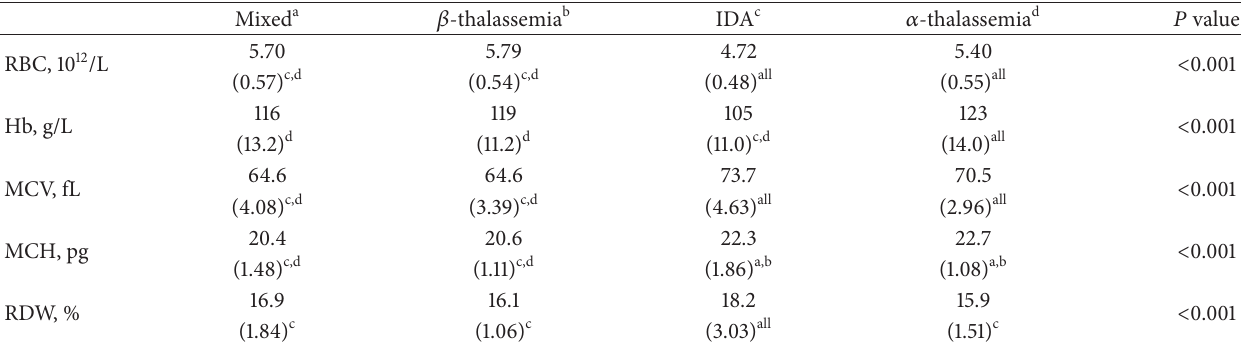
Table 1: Hematological and biochemical data for the study patients comprised 170 with iron deficiency anemia (IDA), 200 𝛽 -thalassemia carriers, 65 𝛼 -thalassemia carriers, and 45 mixed clinical situations (hemoglobinopathy and other disease, iron deficiency, or pregnancy). Values are reported as mean (standard deviation).